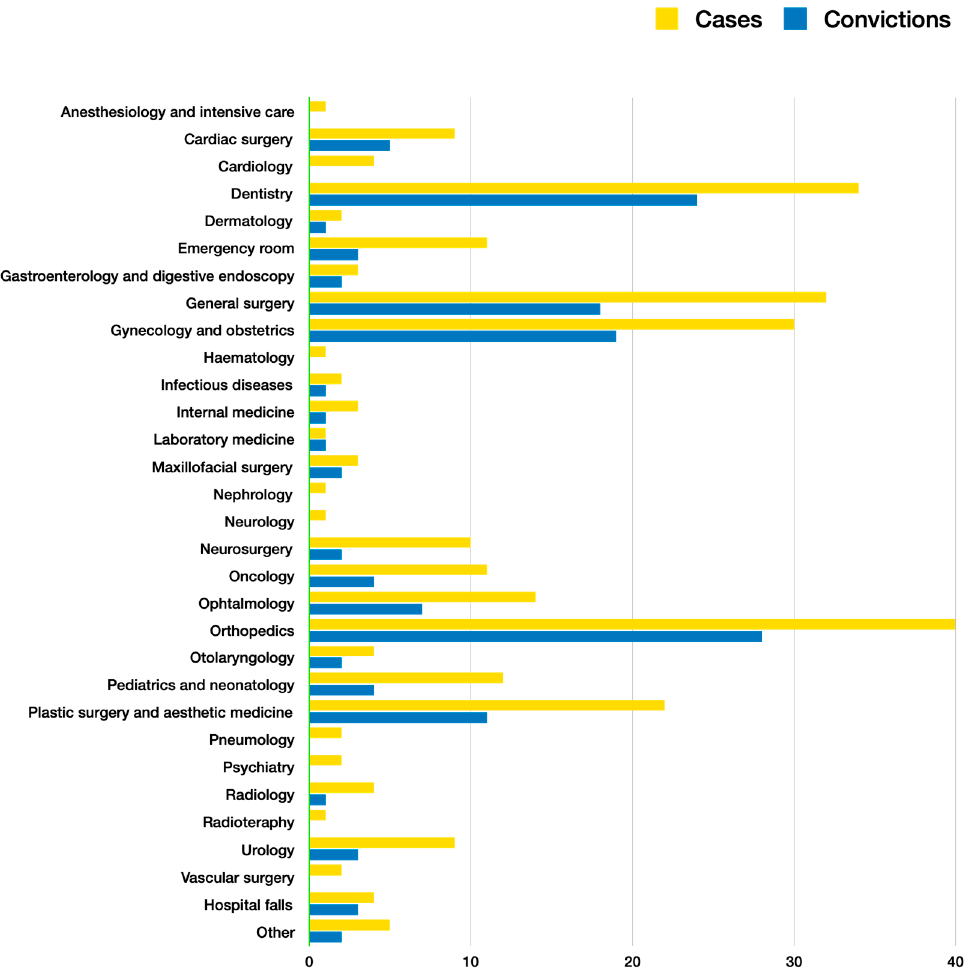
Figure 3. Cases and convictions divided by medical specialty. The ordinates show the branches involved and the abscissae show the number of total cases and the number of convictions. Table 1. Most involved specialties and risk of recognizing liability in